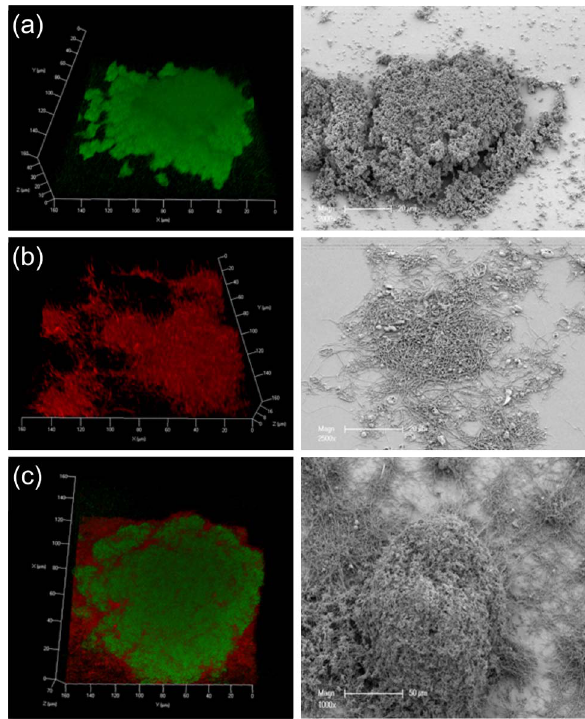
Figure 1. Representative images . Representative images of mature homotypic and polymicrobial biofilms involving P. gingivalis , T. denticola and T. forsythia . Biofilm images were taken 90 h after inoculation of a flow cell. (a) P. gingivalis homotypic biofilm (b) T. denticola homotypic biofilm (c) Polymicrobial biofilms. Bacterial cells were stained with species-specific FISH probes (red, T. denticola ; green, P. gingivalis ). 3D CSLM images are on the left and SEM images are on the